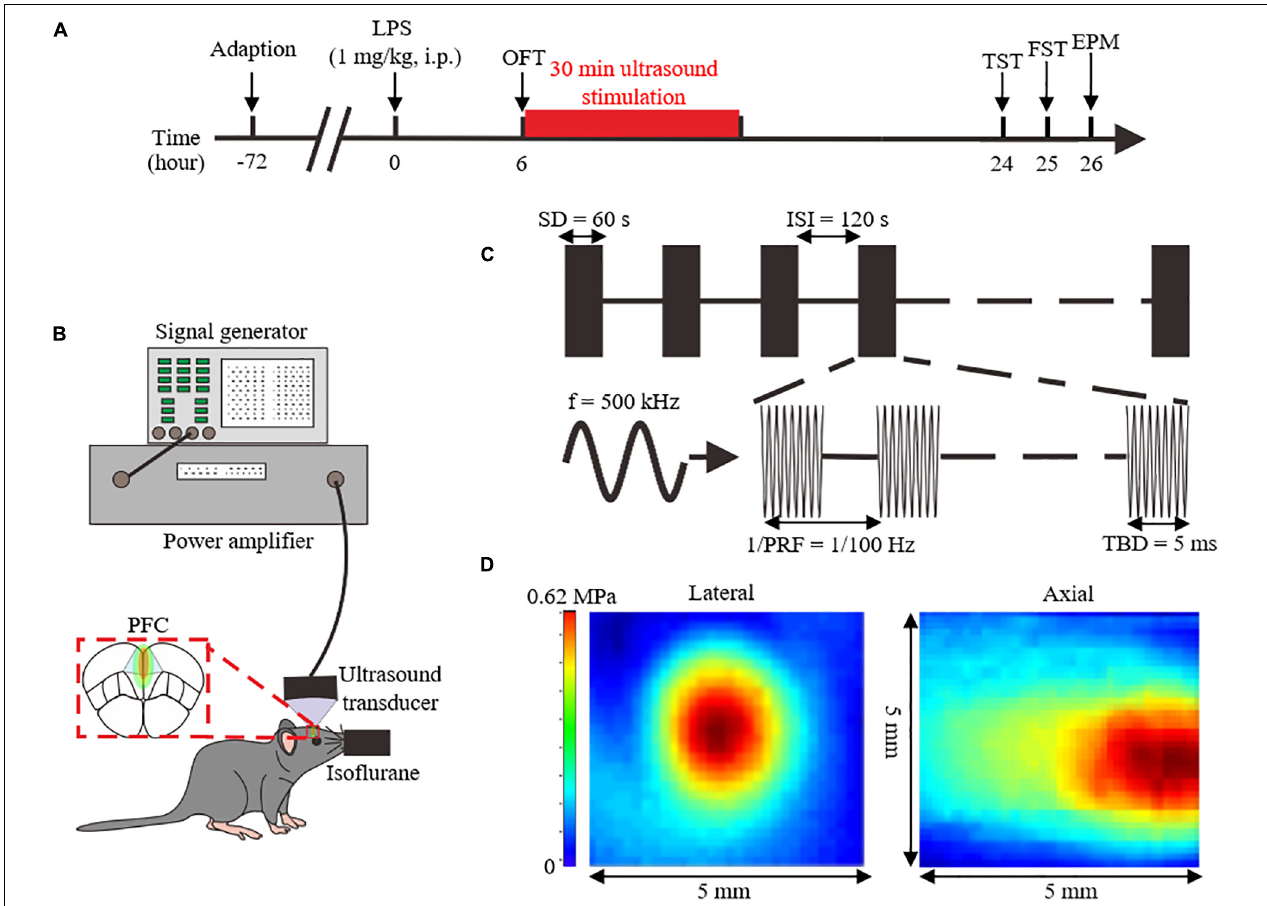
FIGURE 1 | Overview of the experimental design and analyzed parameters. (A) Experimental process flowchart. (B) Schematics of the ultrasound stimulation setup. (C) Illustration of ultrasound stimulation parameters. (D) Acoustic pressure distribution of the lateral and axial direction without skull. LPS, lipopolysaccharide; i.p, intraperitoneal injection; OFT, open field test; FST, forced swimming test; TST, tail suspension test; EPM, elevated plus maze; PFC, prefrontal cortex; SD, stimulation duration; ISI, inter-stimulus interval; f, fundamental frequency; PRF, pulse repetition frequency; TBD, tone-burst